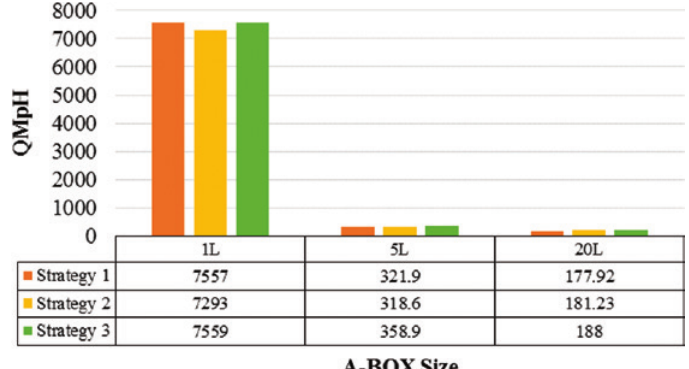
Figure 7: QMpH Analysis of Three Strategies.